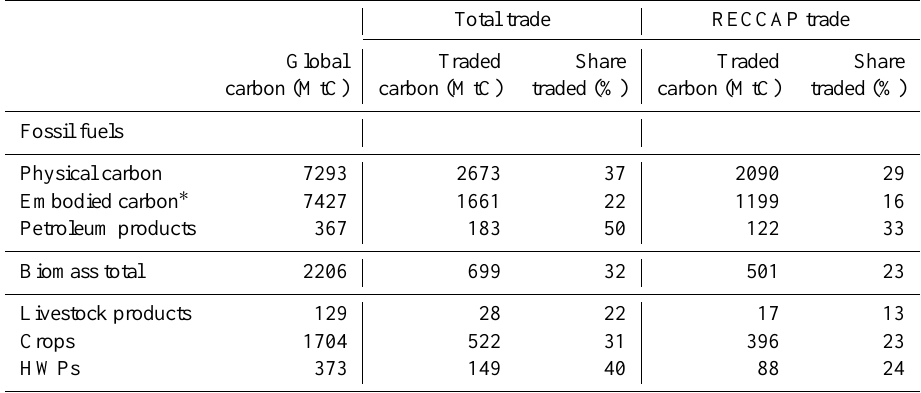
Table 14. A summary of the total and traded carbon associated with different activities (2004). Embodied carbon is emitted in the production of goods and services which are consumed in other countries, while all the other categories are physical flows of carbon. The total biomass includes HWPs, crops, and livestock products. The total trade considers international trade between all 112 countries and regions in our analysis, while RECCAP trade considers only the trade between the RECCAP